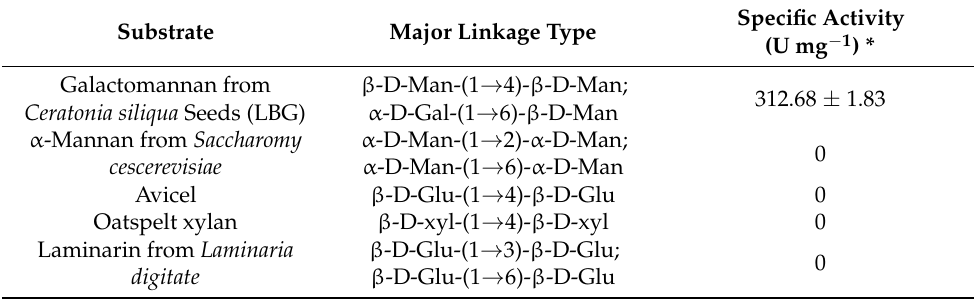
Table 1. The ability of CcMan5C to hydrolyze different polysaccharide